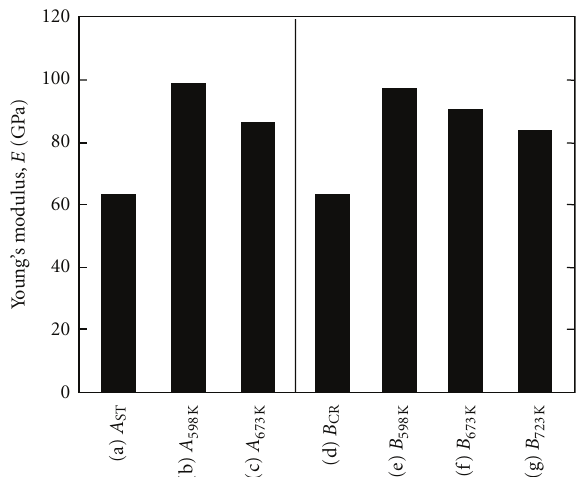
Figure 5: Young’s moduli of elasticity of Ti-29Nb-13Ta-4.6Zr subjected to (a) solution treatment (ST) at 1063 K for 3.6 ks, A ST , (b) aging at 598 K for 259.2 ks after ST, A 598K , (c) aging at 673 K for 259.2 ks after ST, A 673K , (d) cold rolling (CR), B CR , (e) aging at 598 K for 259.2 ks after CR, B 598K , (f) aging at 673 K for 259.2 ks after CR, B 673K , and (g) aging at 723 K for 259.2 ks after CR, B 723K .